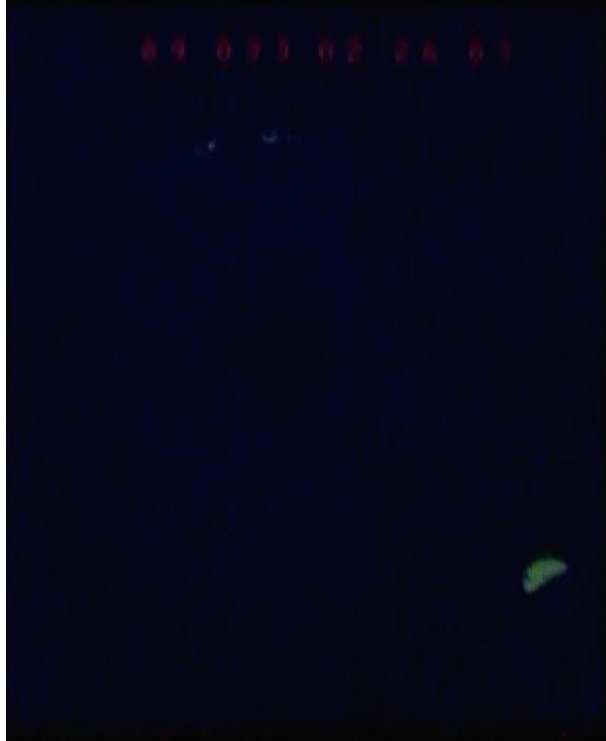
Figure 6. Image C: a poor-quality image with no human-readable digits. Prediction: 89 093 02 26.